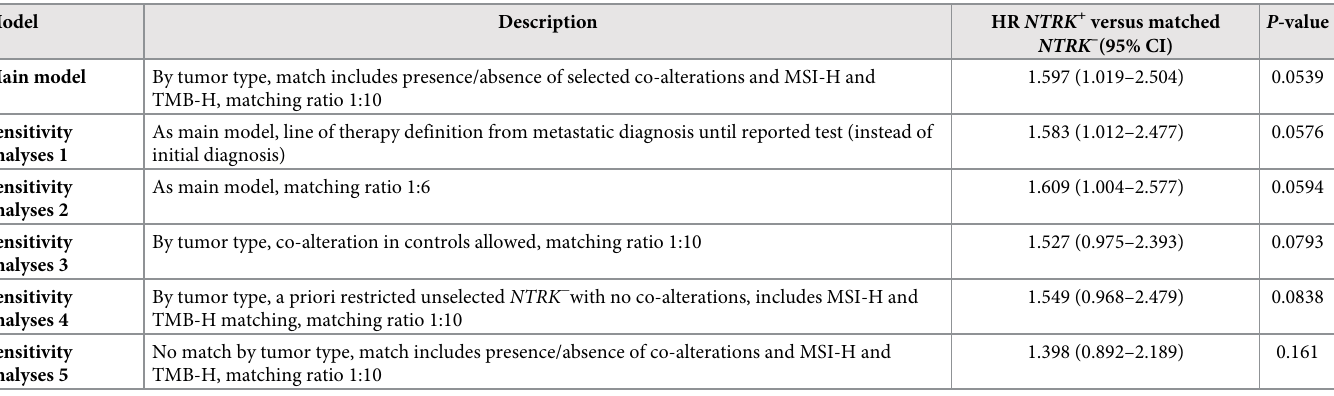
Table 4. Comparison of prognosis results with different matching modeling